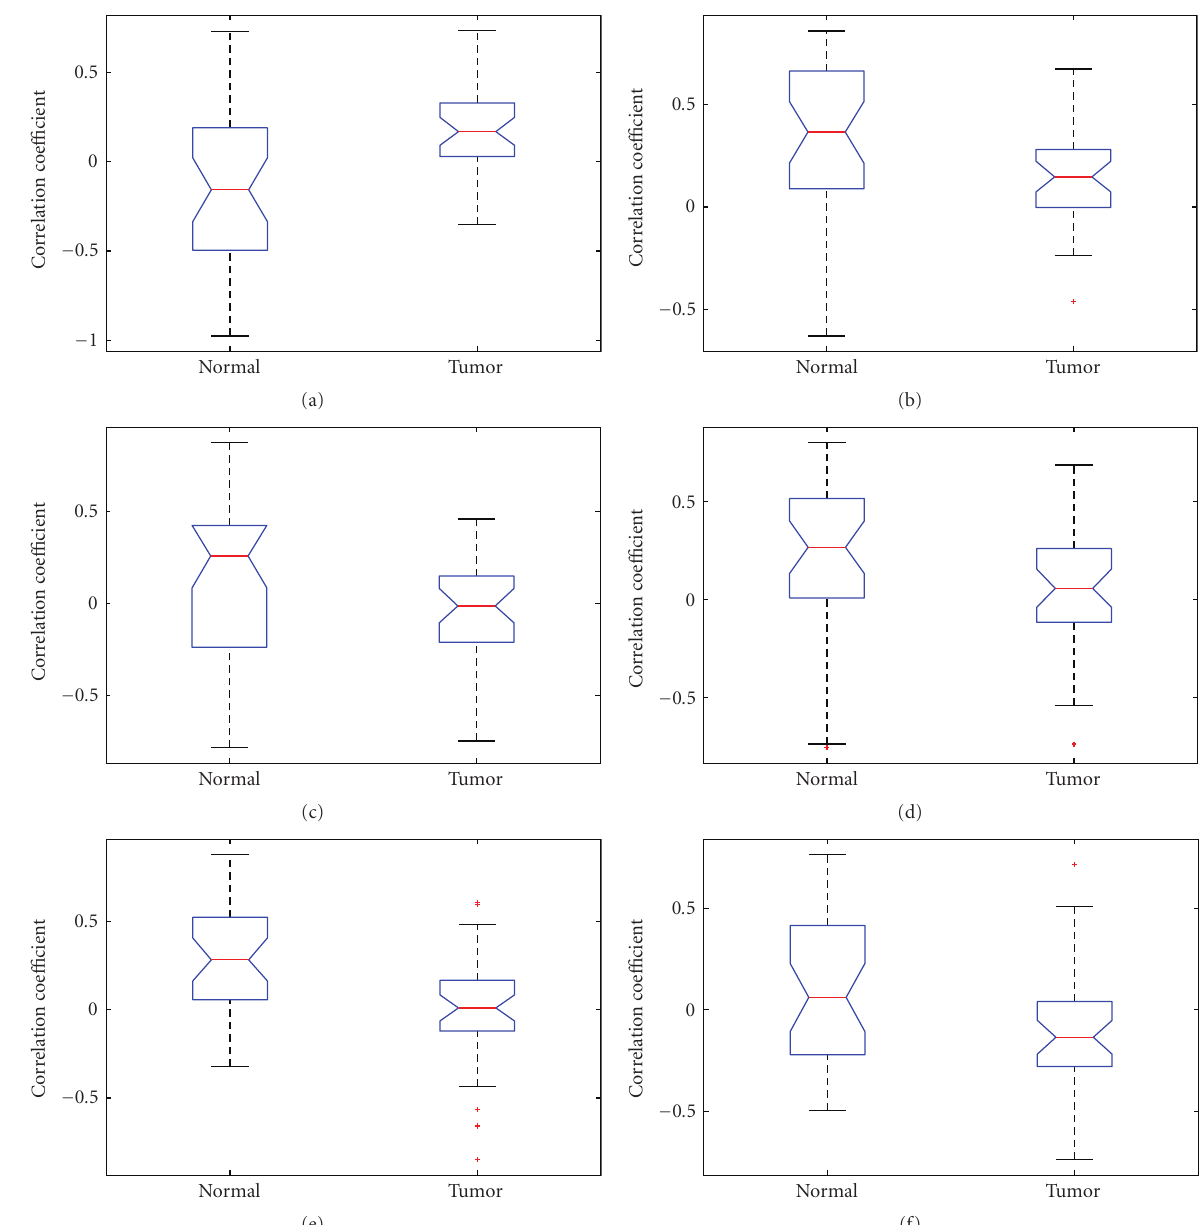
Figure 4: (a) Boxplot for PUMA–Bcl-XL(BCL2L1). Pr( θ < 0 . 05) = 0 . 998. (b) Boxplot for AKT1–BAD. Pr( θ < 0 . 05) = 0 . 859. (c) Boxplot for KRT18–TRADD. Pr( θ < 0 . 05) = 0 . 991.(d) Boxplot for TNFR1–RIPK1(RIP). Pr( θ < 0 . 05) = 0 . 831. (e) Boxplot for